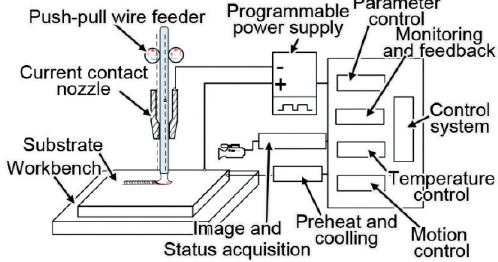
Figure 1. The experimental setup for resistance heating metal wire additive manufacturing .